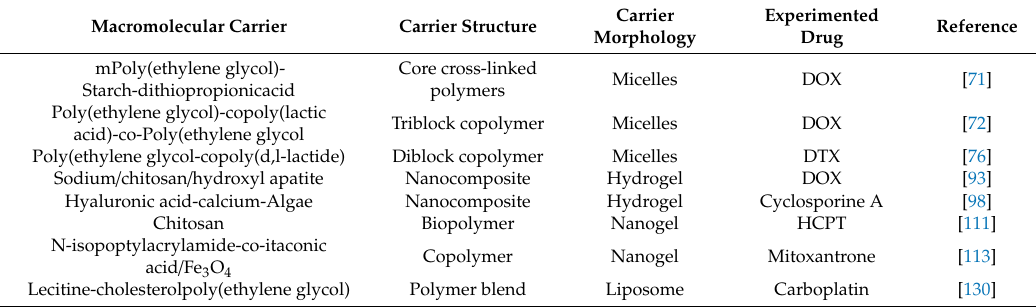
Table 2. Carriers and drugs used in di ff erent